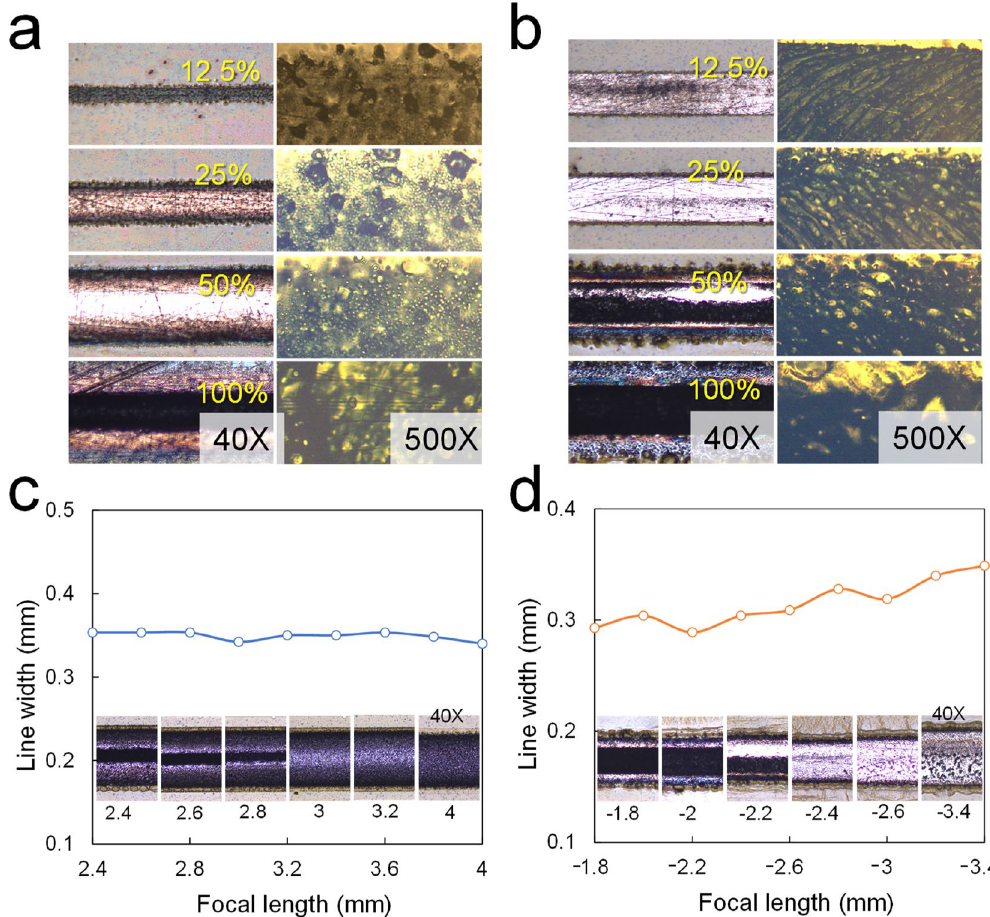
Figure 4. Microscope images of patterned Cu as a function of input PWM signal ratios from 12.5 to 100%: ( a ) Cu lines formed at LFL and 4 mm/s scan speed, ( b ) at SFL and 4 mm/s scan speed. Microscope images and linewidth of Cu patterns formed at various SFLs and LFLs to find the proper focal distance to minimize defects: ( c ) Focal distance (LFL) from 2.4 to 4 mm, ( d ) focal distance (SFL) from − 1.8 to − 3.4 mm based on the RFL. Note that the Cu patterns were obtained at 38% PWM input and 4 mm/s scan